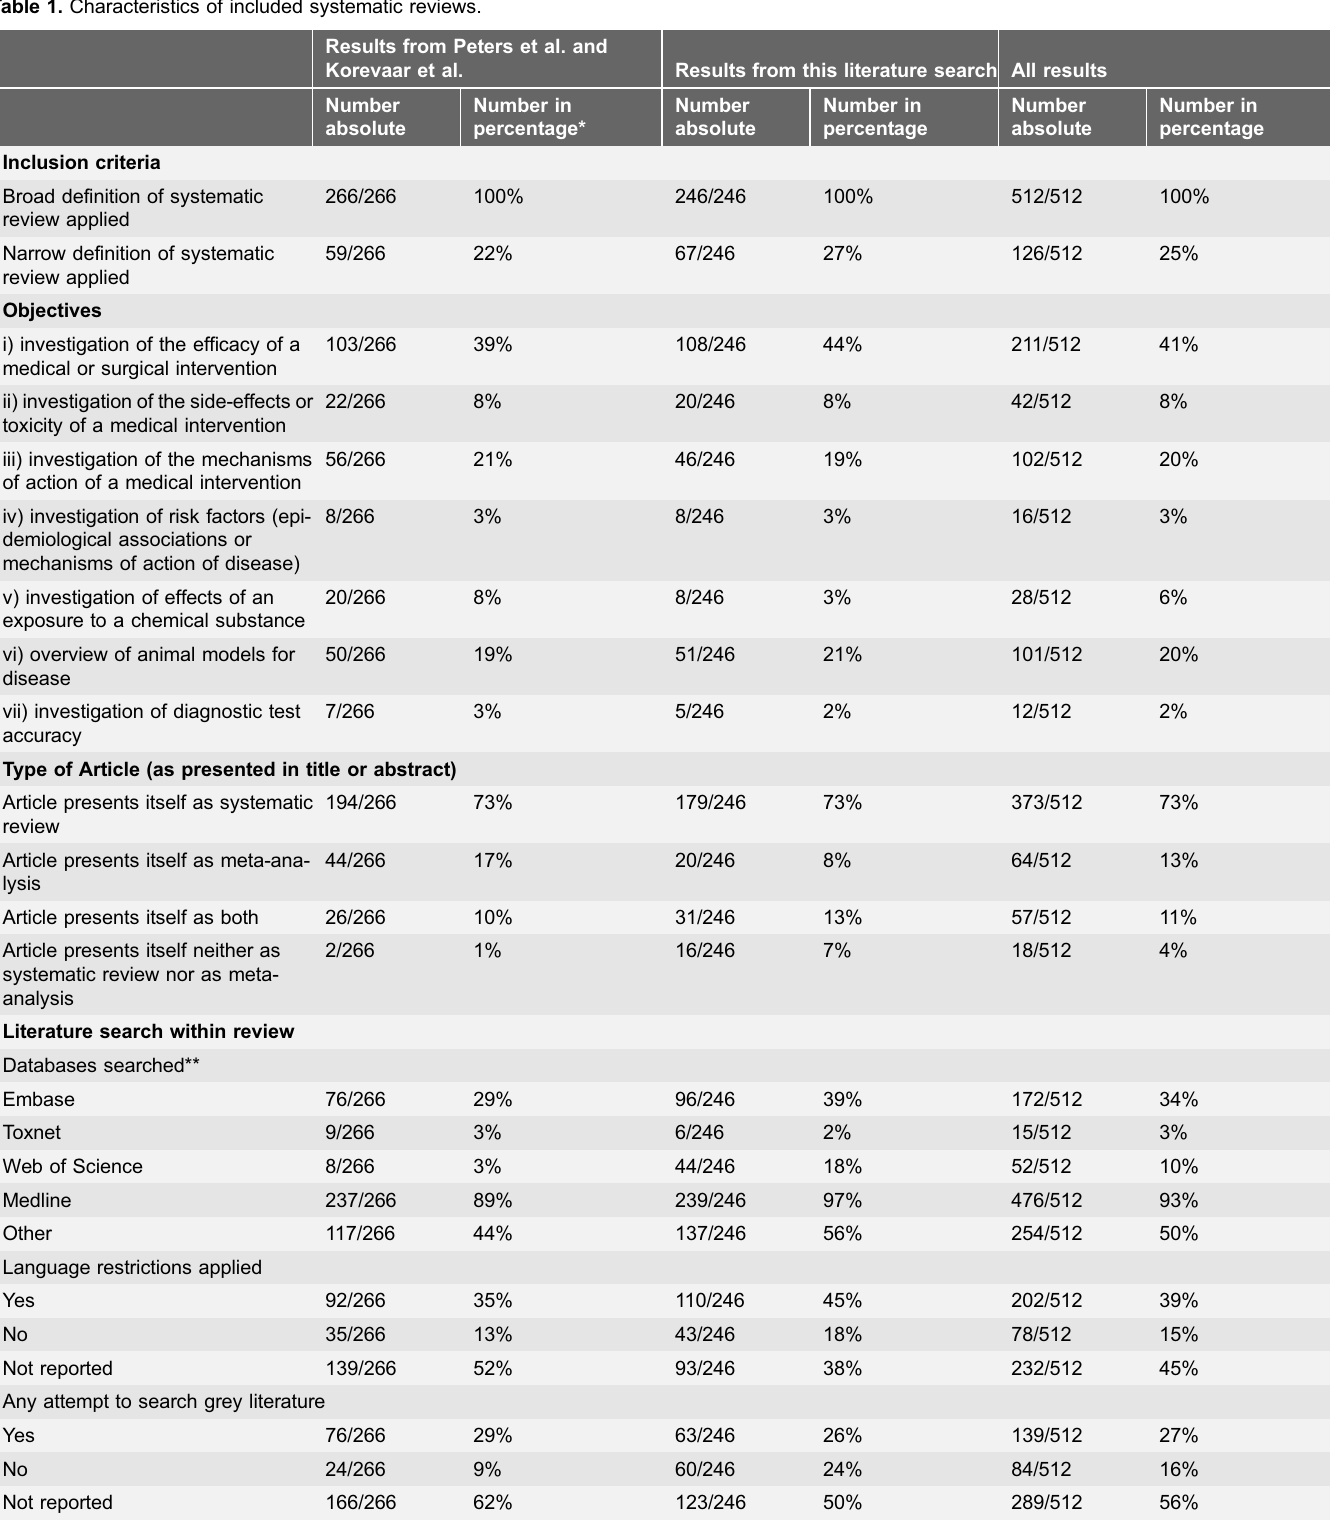
Table 1. Characteristics of included systematic